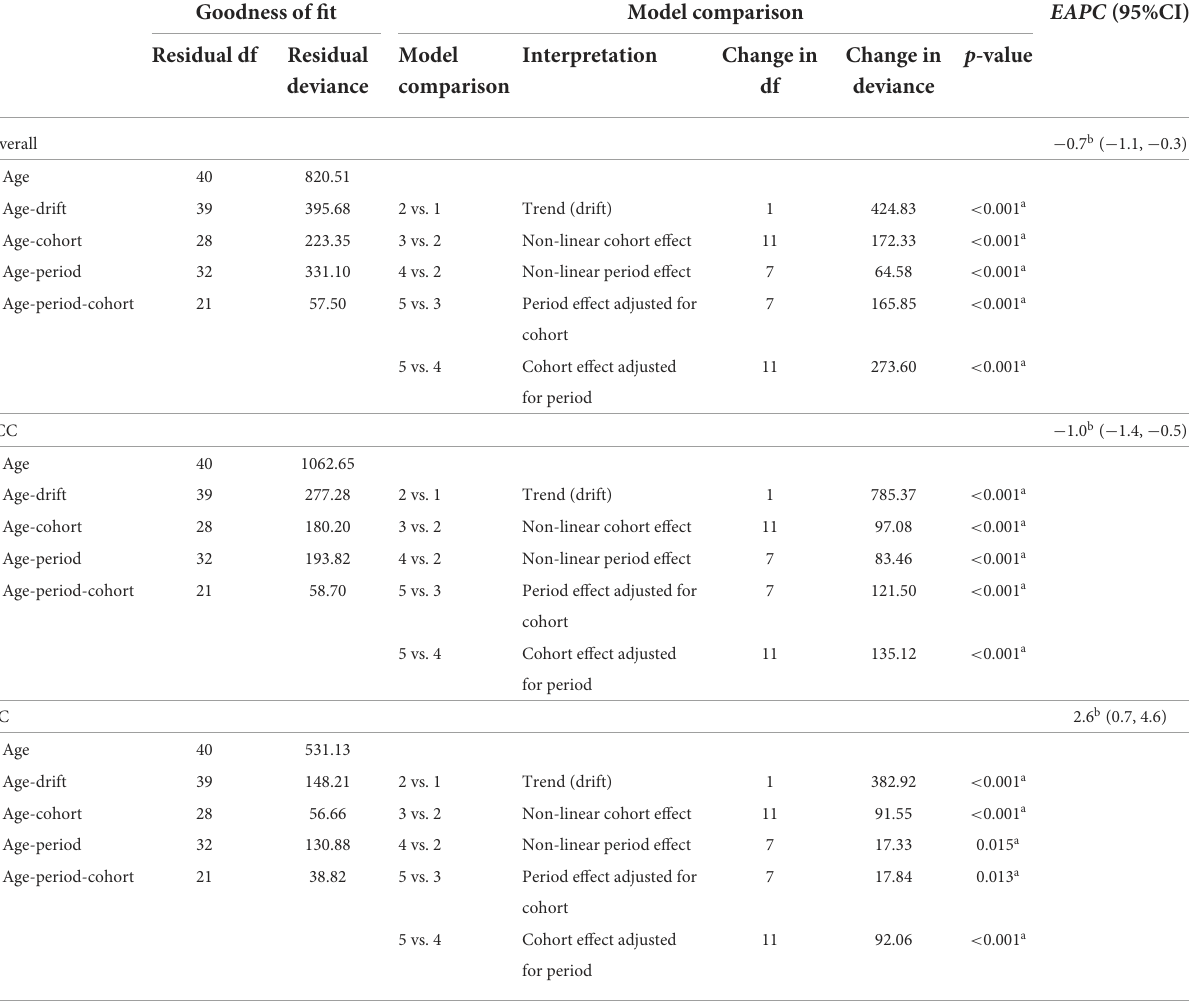
TABLE 4 Age-period-cohort models for cervical cancer incidence among 20–44-year group females in US, by histological subtype,